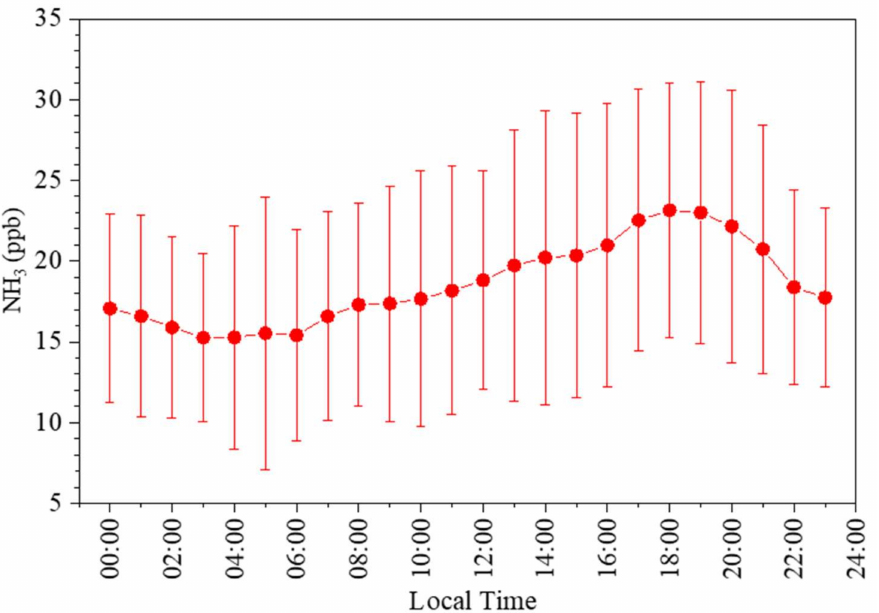
Figure 4. Hourly concentrations and standard deviations of the atmospheric NH 3 in the urban area of Jeonju from 1–30 June